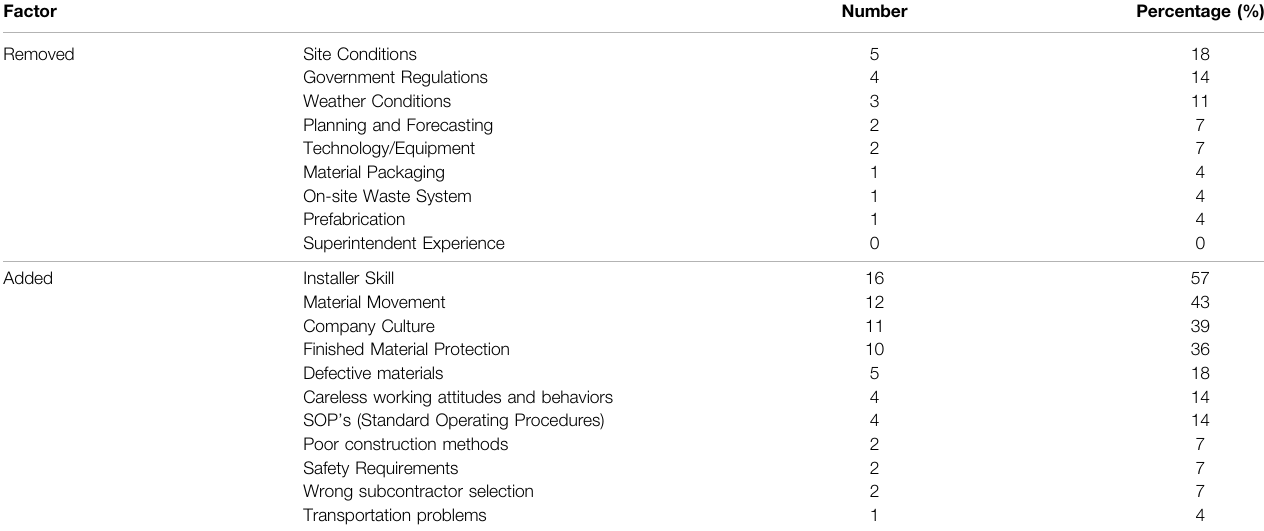
TABLE 4 | Factors removed from or added to the original list provided in Round